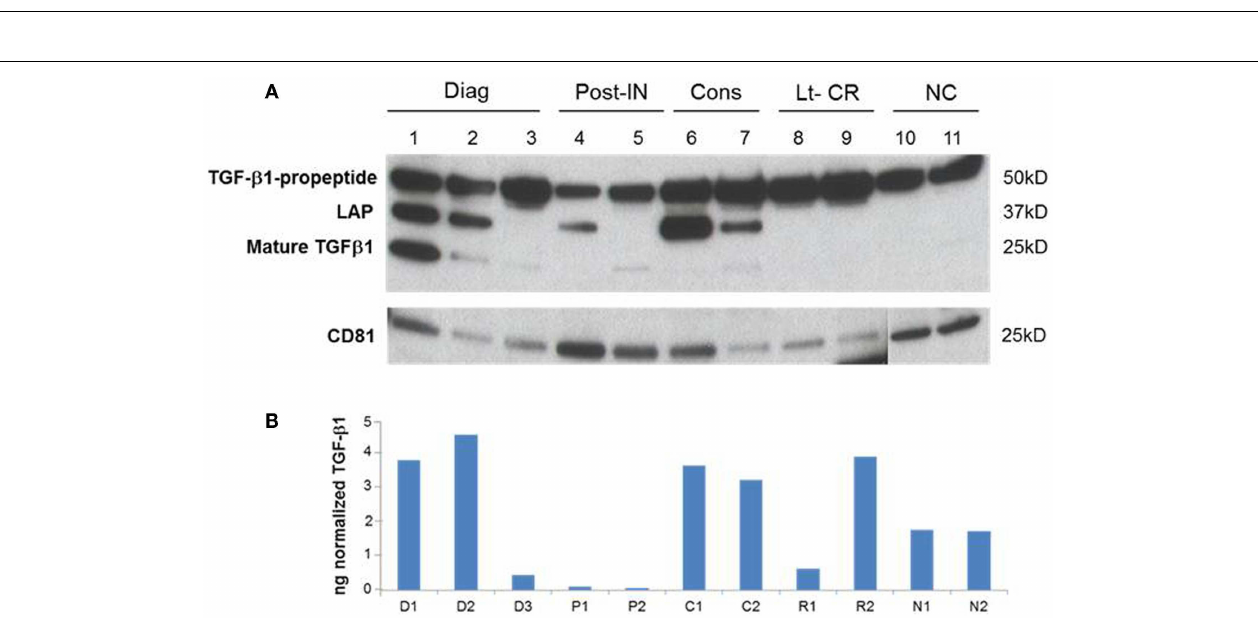
FIGURE 2 | Protein levels and solubleTGF- β 1 levels in exosomes isolated fromAML patients’ plasma . (A) Exosomal protein levels (in microgram per milliliter plasma) for all patients in different cohorts: Diag, at AML diagnosis; post IN, 14days after starting induction CT; Cons, during consolidation CT; lt-CR, long-term complete remission; NC, normal control. (B) Exosomal protein levels in serial plasma samples